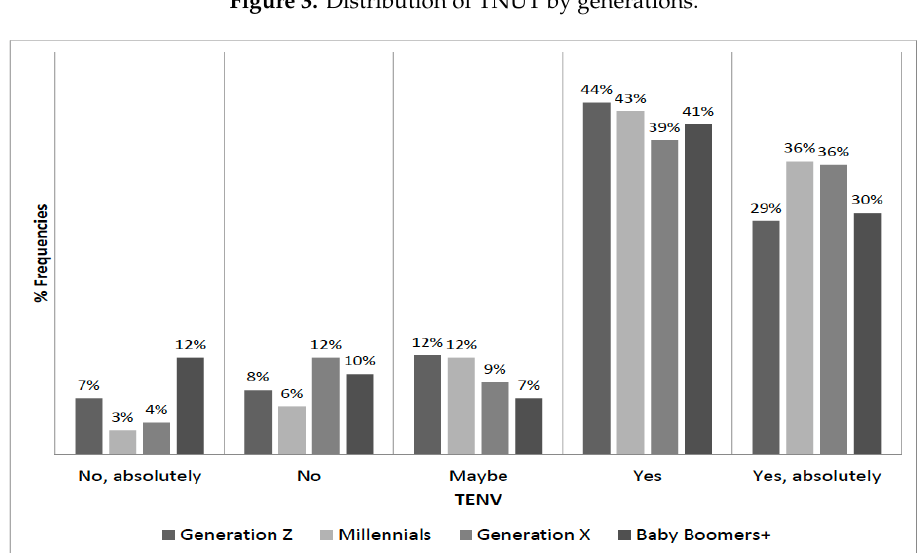
Figure 4. Distribution of TENV by generations.